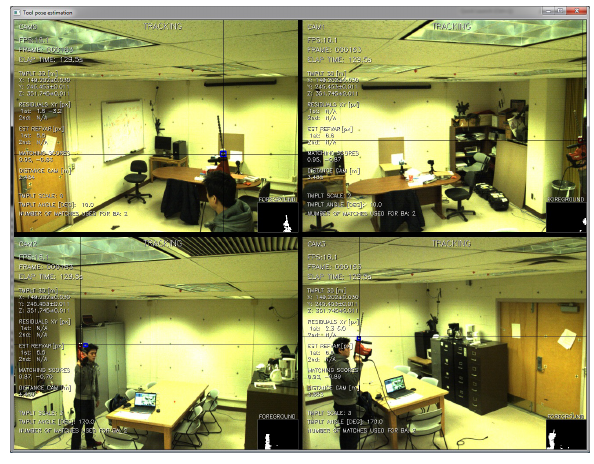
(±5.0pixel), the refinement process decides that the detection variances of different camera sets. The yellow rectangle